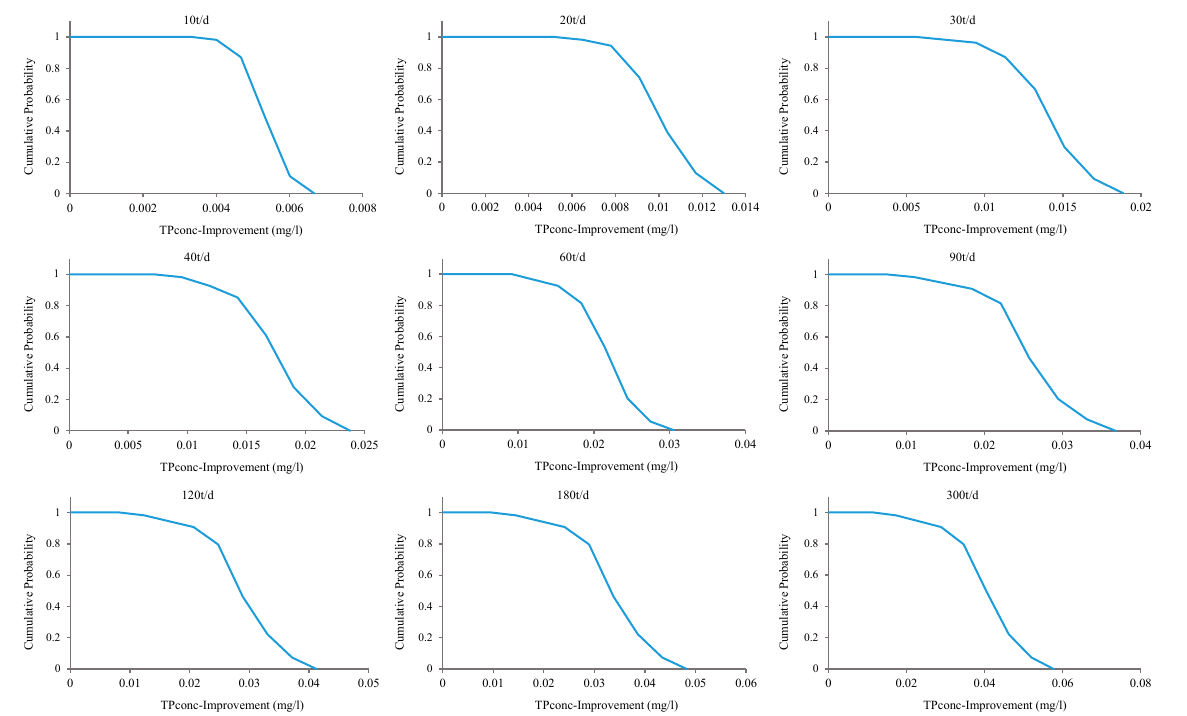
Figure 15. Cumulative probability distribution of response for each dose level.